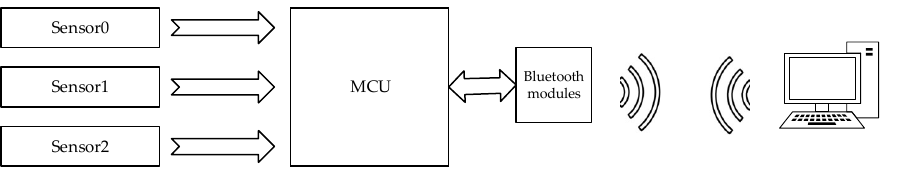
Figure 18. Schematic diagram of the electric field measurement system.